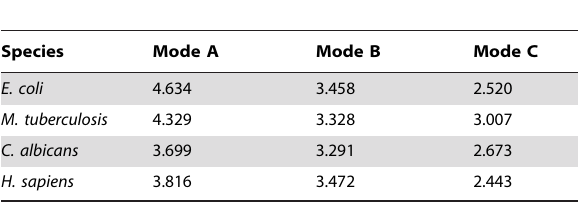
Table 3. Degree of coupling of the slow conformational modes to the hydride transfer catalyzed by